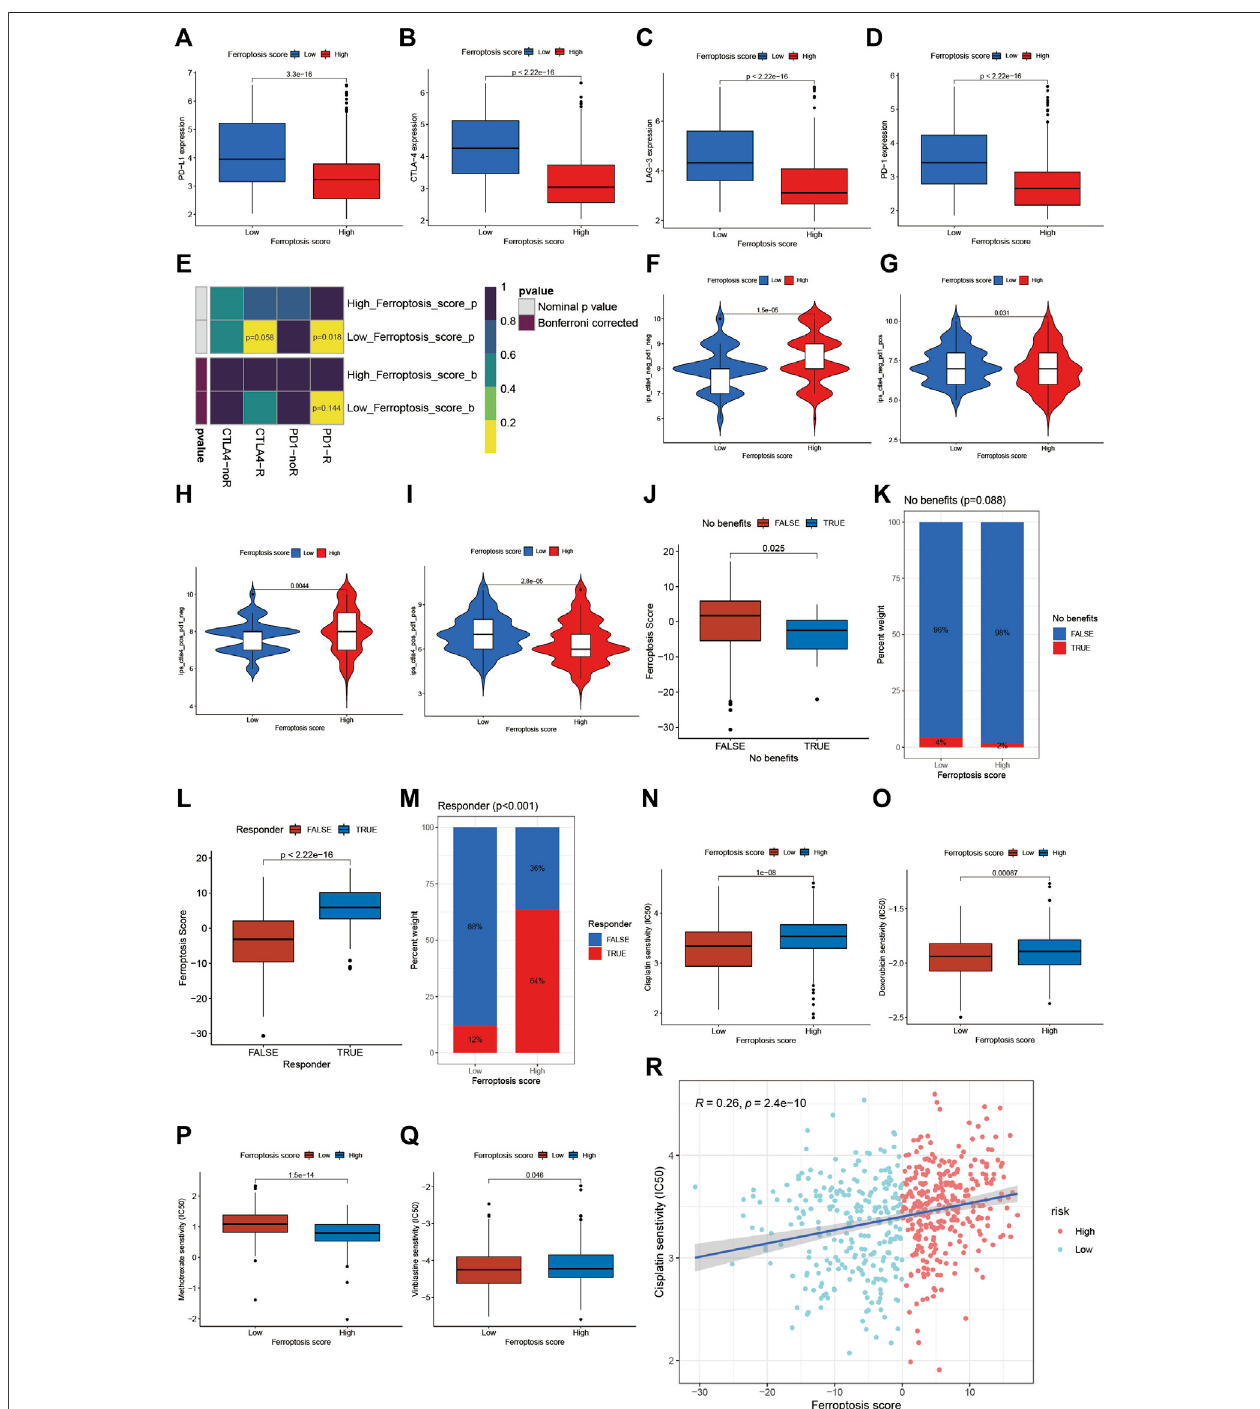
FIGURE 7 | Role of ferroptosis patterns in immunotherapy and chemotherapy. (A) Differences in the expression of PD-L1 between the high and low ferroptosis score groups in meta-cohort ( p < 0.001, Wilcoxon test). (B) Differences in the expression of CTLA-4 between high and low ferroptosis score groups in meta-cohort ( p < 0.001, Wilcoxon test). (C) Differences in the expression of LAG-3 between high and low ferroptosis score groups in meta-cohort ( p < 0.001, Wilcoxon test). (D) DifferencesintheexpressionofPD-1betweenhighandlowferroptosisscoregroupsinmeta-cohort( p < 0.001,Wilcoxontest). (E) Thesimilarityofgeneexpression pro fi les between ferroptosis score and BCa patients treated with immune checkpoint blockade (ICB). CTLA4-noR, patients no respond to anti-CTLA4 treatment, CTLA4-R, patients respond to anti-CTLA4 treatment, PD1-noR, patients no respond to anti-PD-1 treatment, PD1-R, patients respond to anti-PD-1 treatment. (F – I) Violindiagramshowedthedifferencesofresponseindexbetweenhighandlowferroptosisscoregroupsinfoursubgroups. (F) Ifnoimmunotherapywasconducted,the